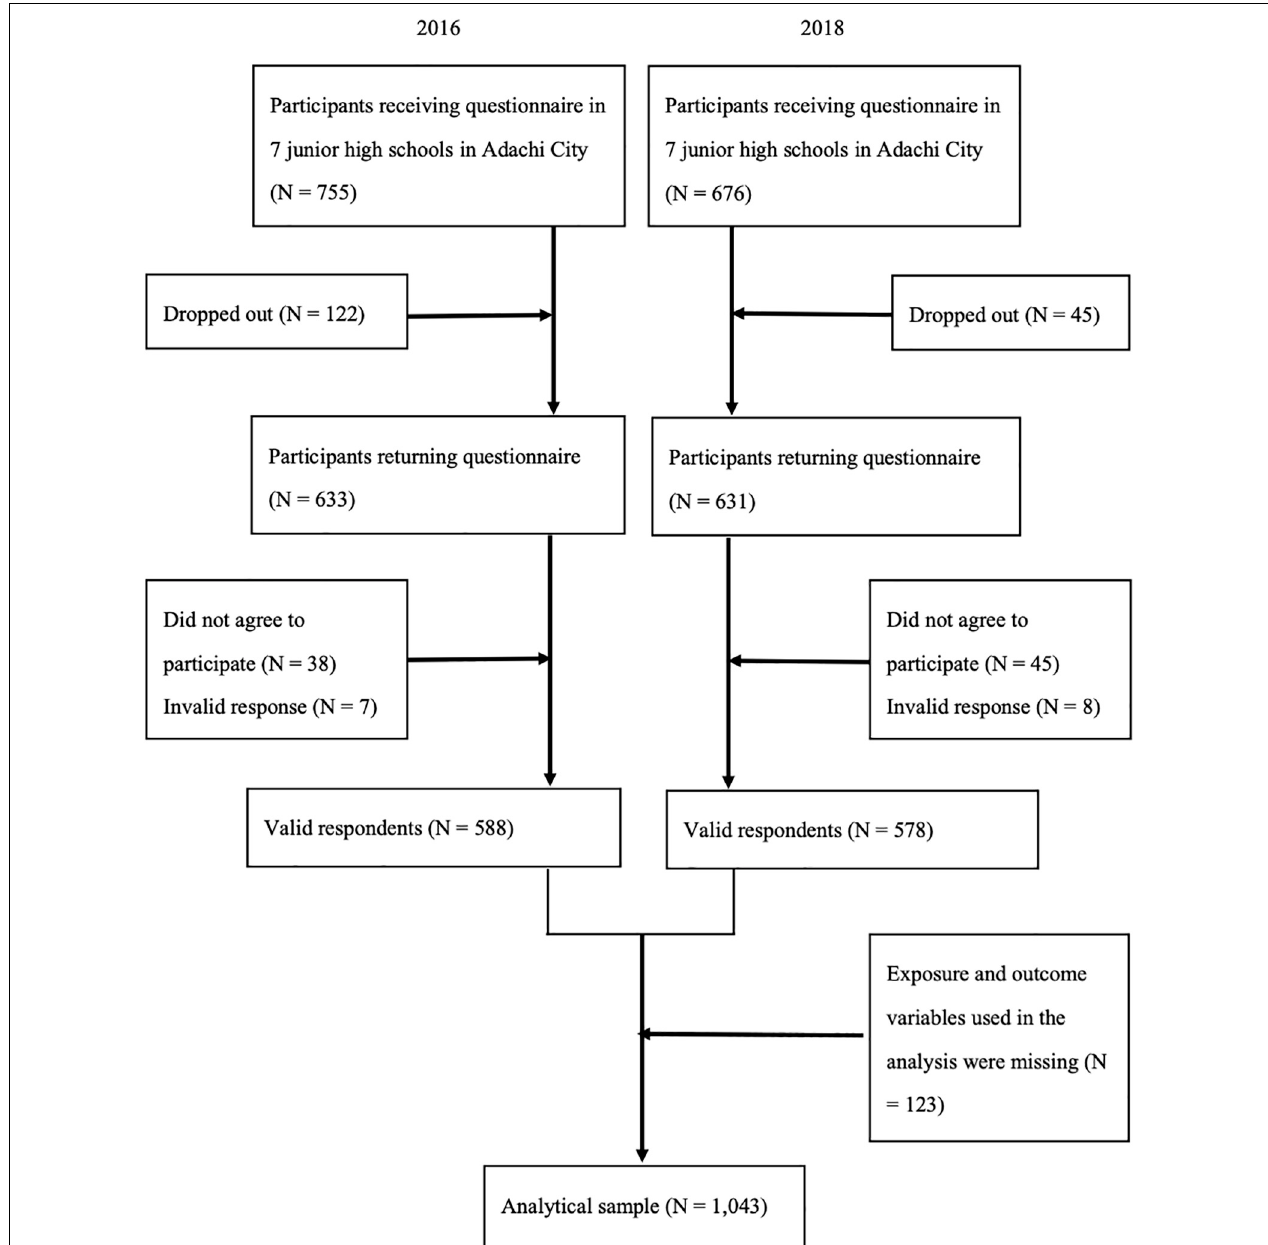
FIGURE 1 | Participant flow